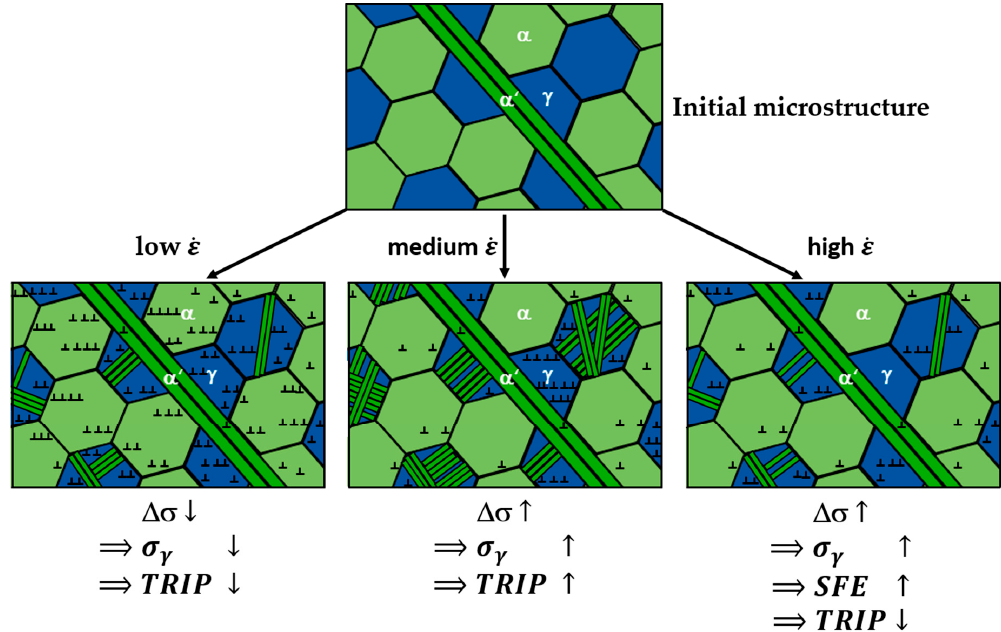
Figure 13. Impact of the strain-rate-dependent strength of α and α ’ relative to γ ( ∆ σ ) on the microstructural evolution during straining at different strain rates.